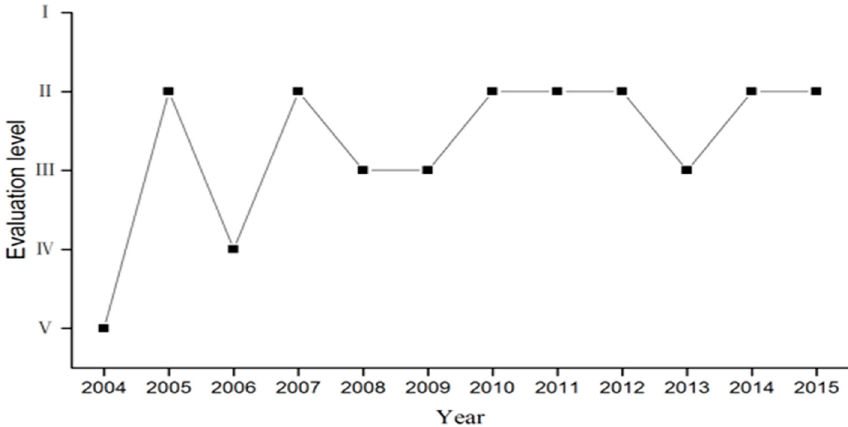
Figure 2. The evaluation level determined by SPAro from 2004 to 2015.